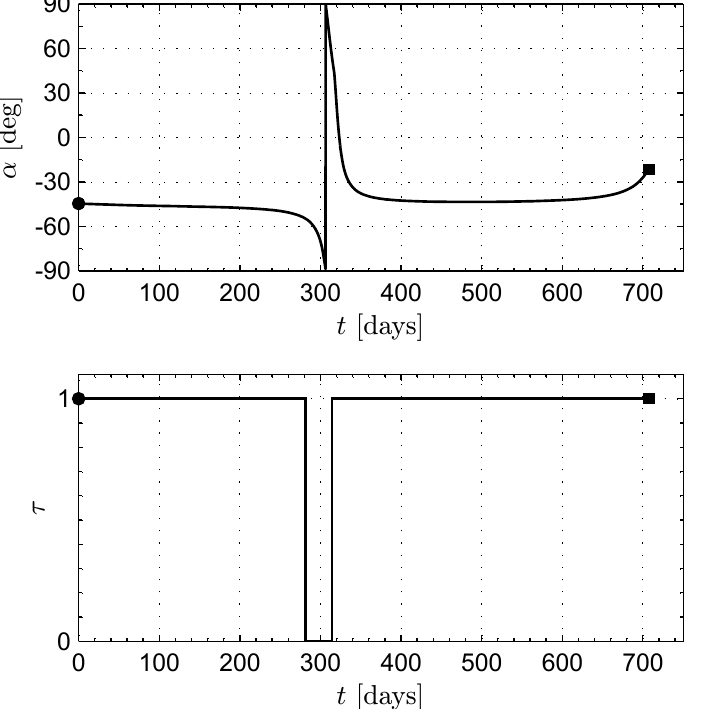
Figure 7. Time variation of the sail pitch angle α and switching parameter τ when a c = 1.5mm/s 2 . Black circle → starting point; black square → arrival